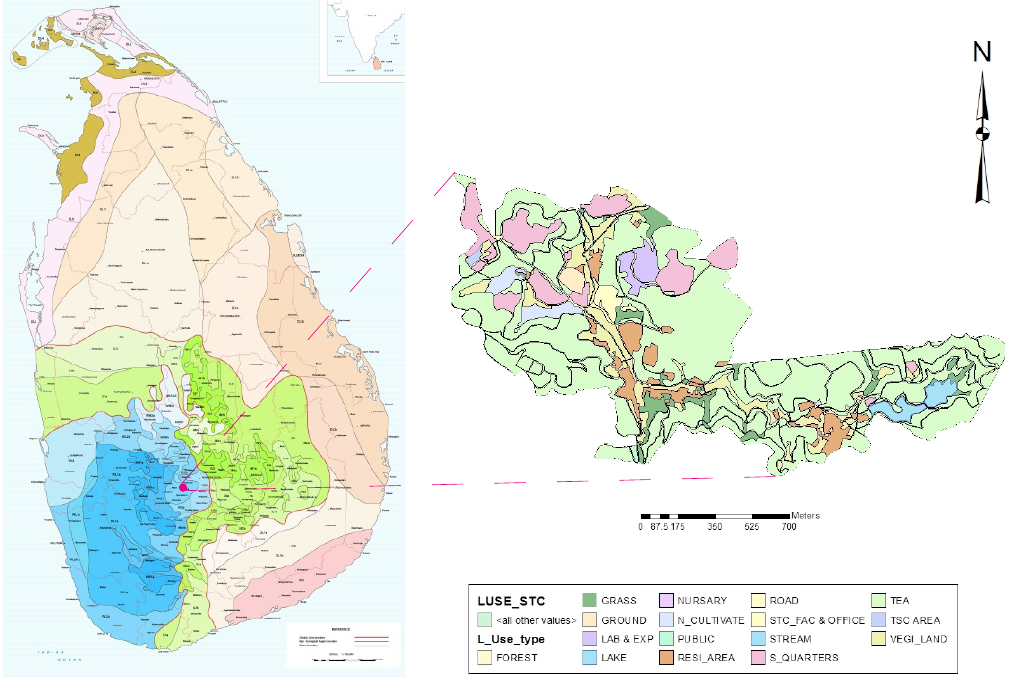
Figure 1. Agro-ecology map of Sri Lanka; 1B- Land use map of the St. Coombs Tea Estate (Upper & Low Divisions) Talawakele